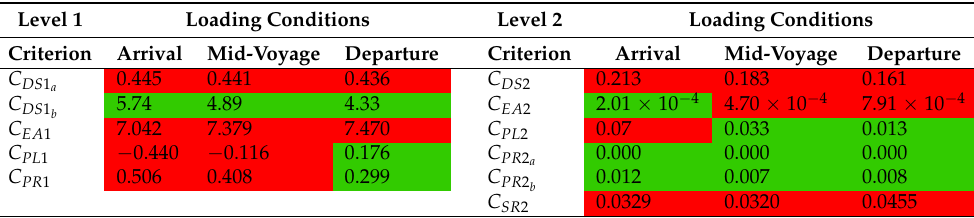
Table 5. Comprehensive assessment of SGISc vulnerability levels for Y03. Criteria compliant with the standard are highlighted in green. Criteria not compliant with the standard are highlighted in red.